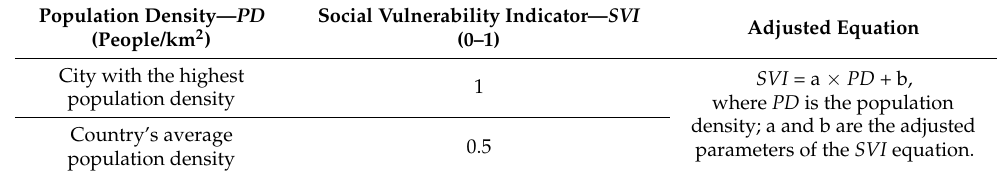
Table 4. Social vulnerability indicator